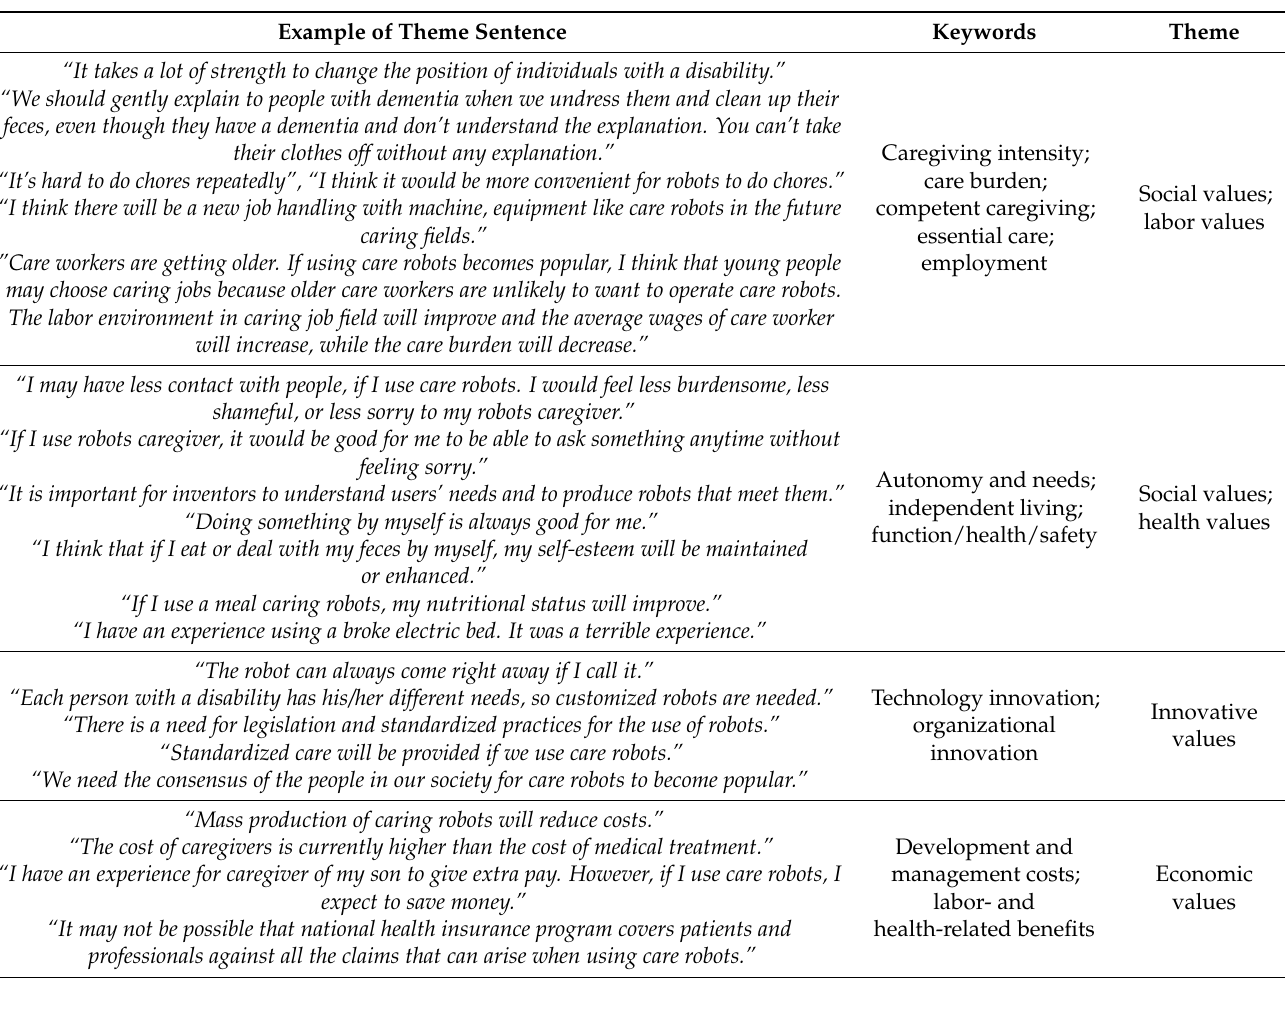
Table 2. The result of FGIs: keywords and themes regarding social values of care